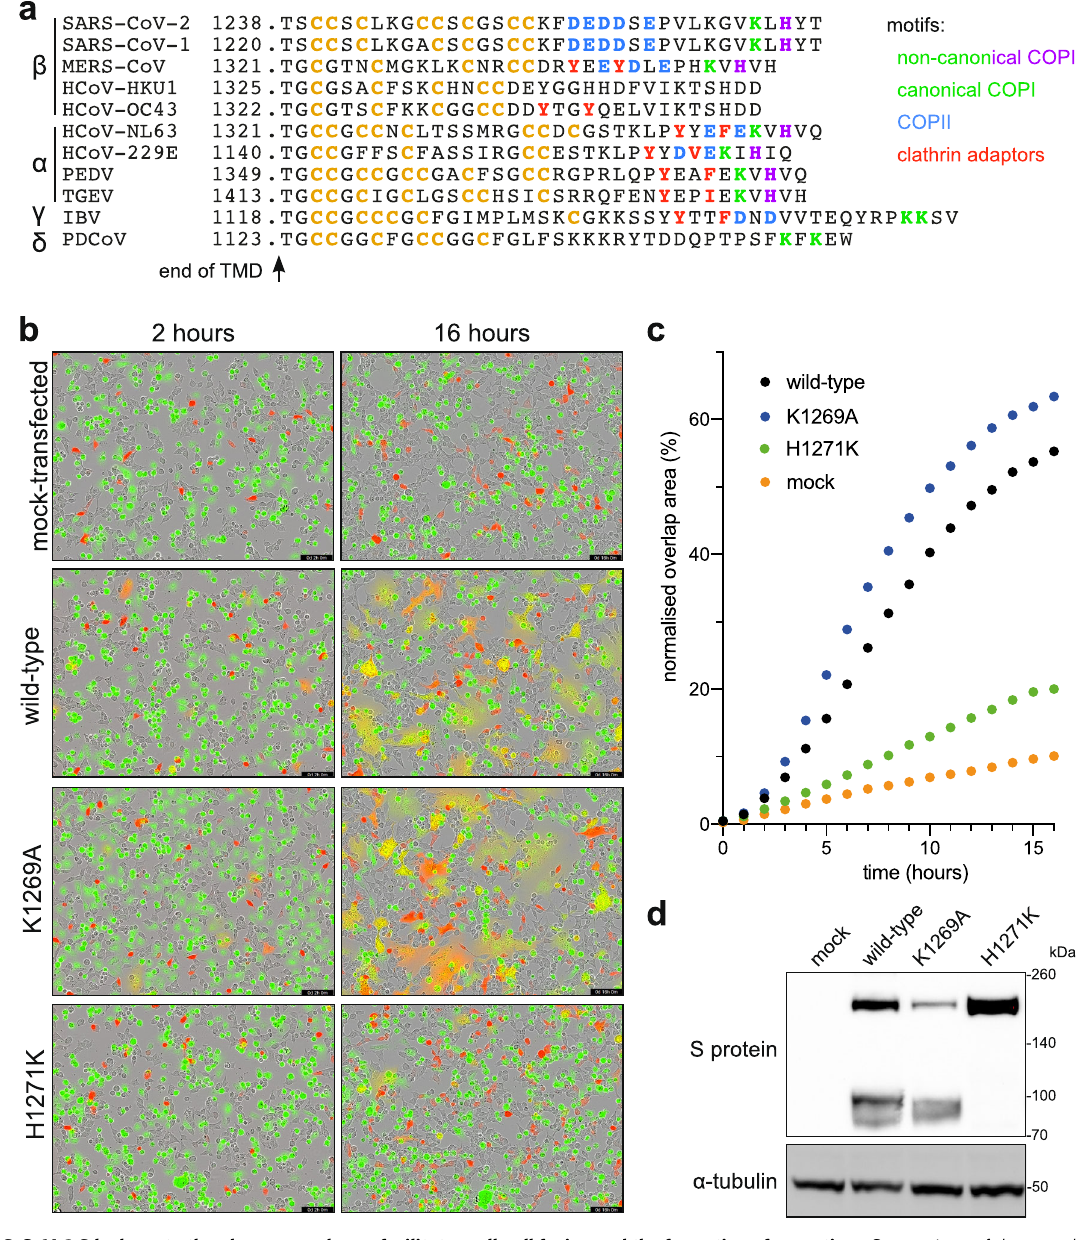
Fig. 5 SARS-CoV-2 S leakage to the plasma membrane facilitates cell-cell fusion and the formation of syncytia. a Comparison of the cytoplasmic tails of S proteins from the four genera of Coronaviridae, aligned by their TMDs. Binding motifs for traf fi cking proteins are indicated, along with cysteine residues (orange). b Representative micrographs showing 293T cells coexpressing mCherry and different full-length S variants fusing with acceptor Vero cells stained with CellTracker Green. Cell fusion is monitored by overlap between the green and red signal. Retention of S in the ER reduces its capacity to form syncytia while increased leakage to the plasma membrane increases it. Scale bars: 200 µ m. c Quanti fi cation of cell-cell fusion as percentage of the fi eld showing green and red overlap. Mean of two biological replicates (see Source Data fi le). d Immunoblots from 293T cells expressing the indicated full- length S variants, with the H1271K mutation preventing the protein from reaching the site of S1/S2 cleavage by furin in the late Golgi. Representative of two independent